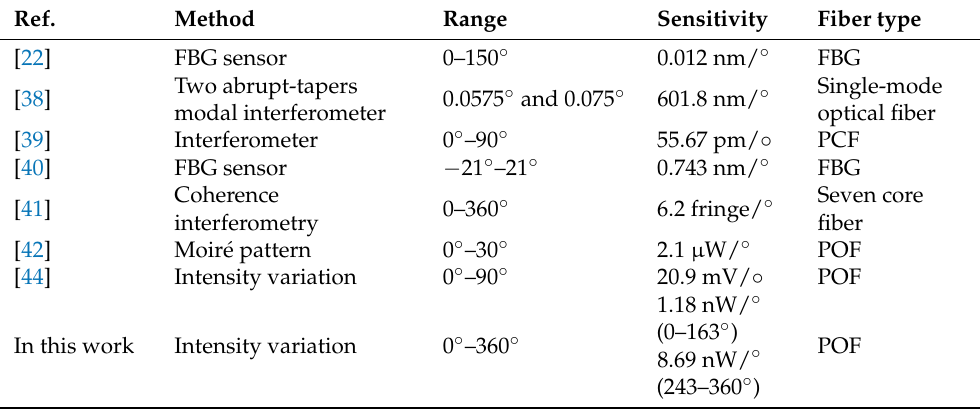
Table 3. Comparison of rotational